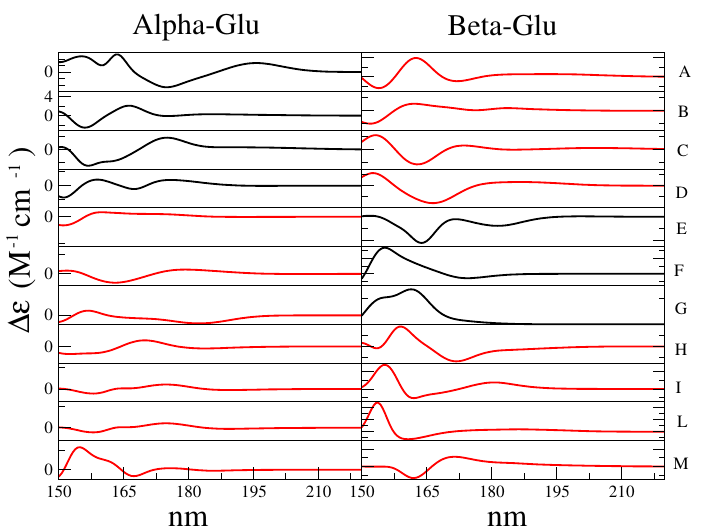
Figure 8. Calculated ECD spectra of the RC conformations reported in Table 1. For the sake of clarity, we have omitted the values on the y-axis. The names of the species, reported on the right side, are the same as in Table 1. In red, we have indicated the GG rotamers, and in black, the GT rotamers.